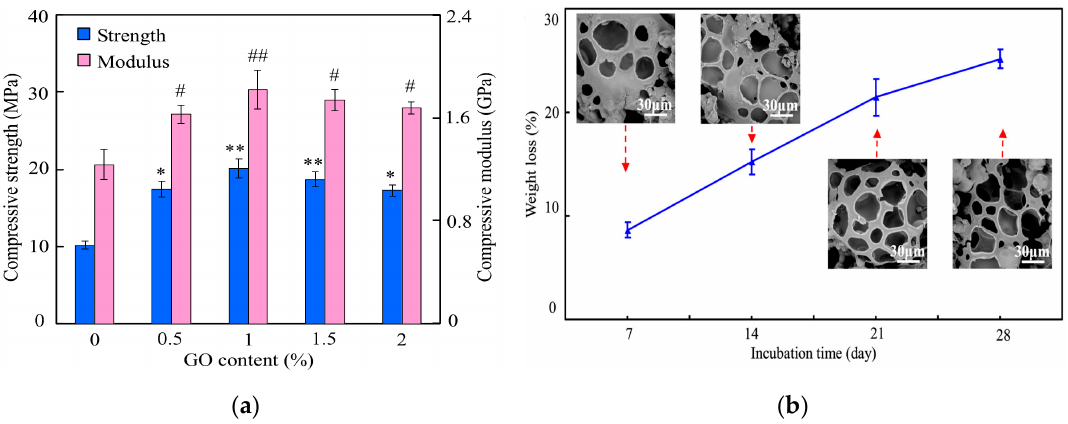
Figure 36. ( a ) Compressive strength and compressive modulus of porous PEEK-PVA scaffolds as a function of GO content. # denotes statistically significant difference between compressive strength of the scaffolds ( p < 0.05), * denotes statistically significant difference between compressive modulus of the scaffolds ( p < 0.05). ( b ) Weight loss vs time of PEEK-PVA/1 wt% GO scaffold upon immersion in PBS at 37 °C for 28 days. Reproduced from [221] with permission of Taylor & Francis. Table 3. The strengths and weaknesses of 3D-printed PEEK-based scaffolds. Scaffold Strengths Weaknesses